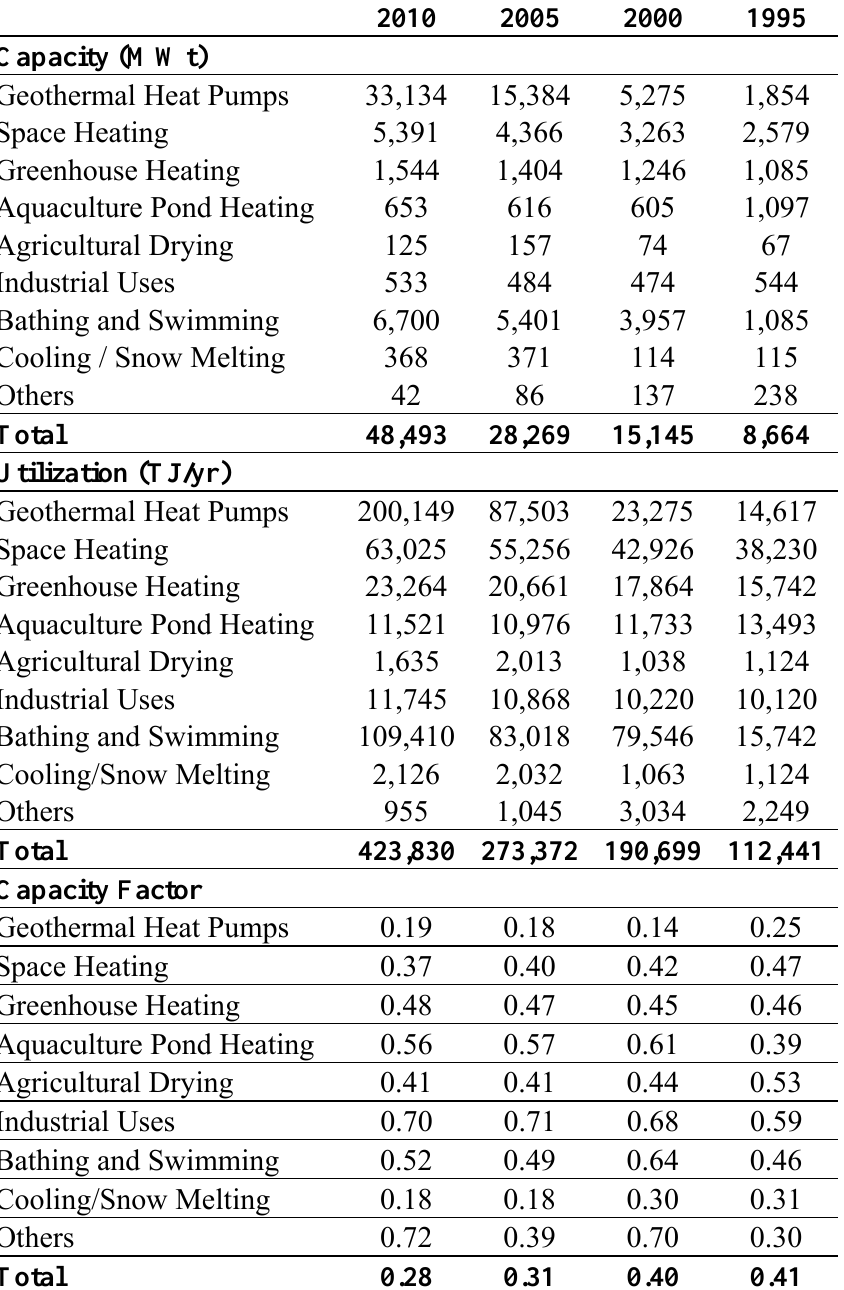
Table 2. Summary of the various categories of direct use worldwide, referred to the period 1995–2010